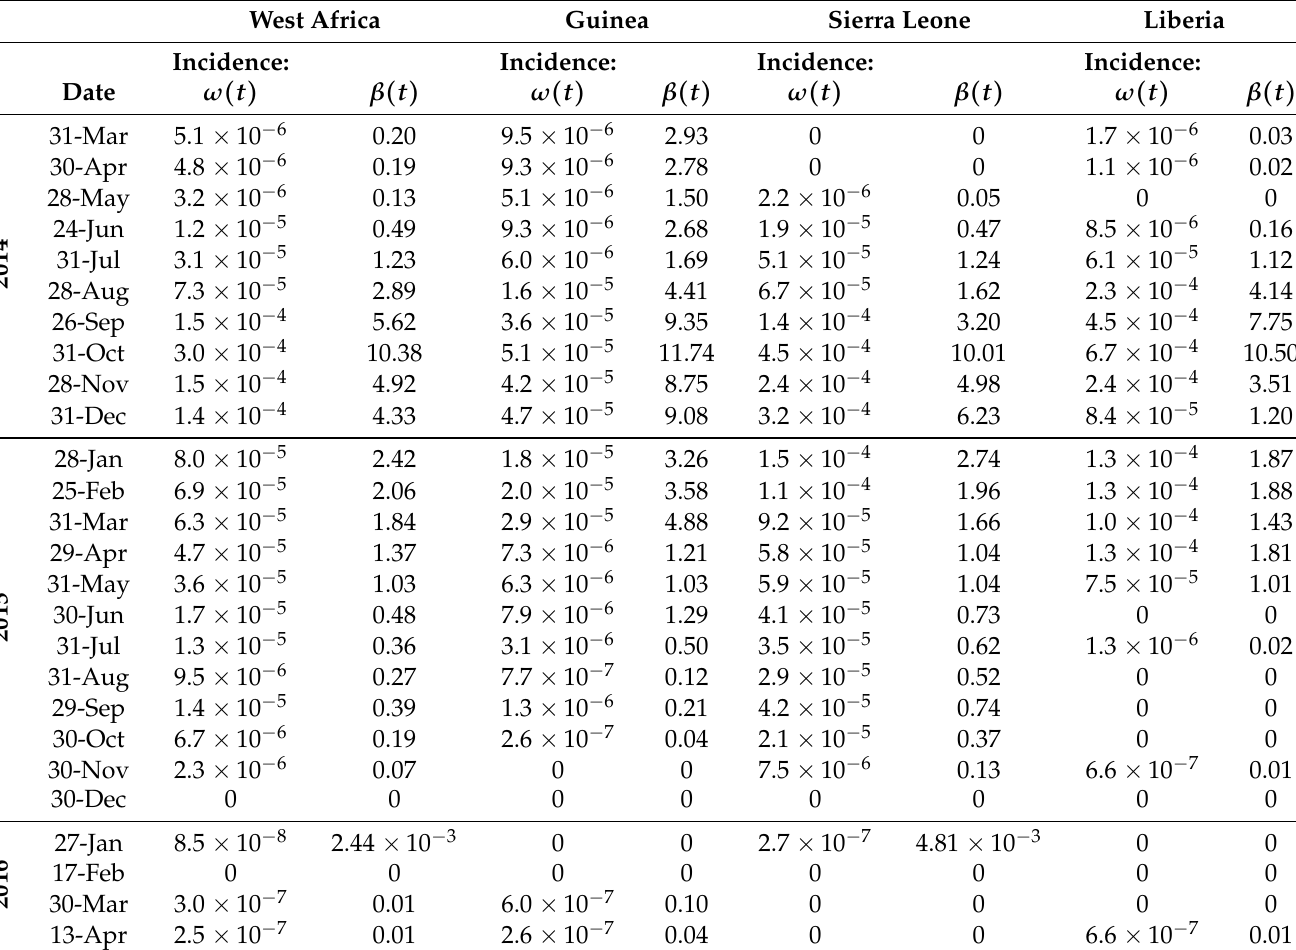
Table A1. 2014–2016 Ebola outbreak in West Africa. Estimates of β ( t ) for incidence